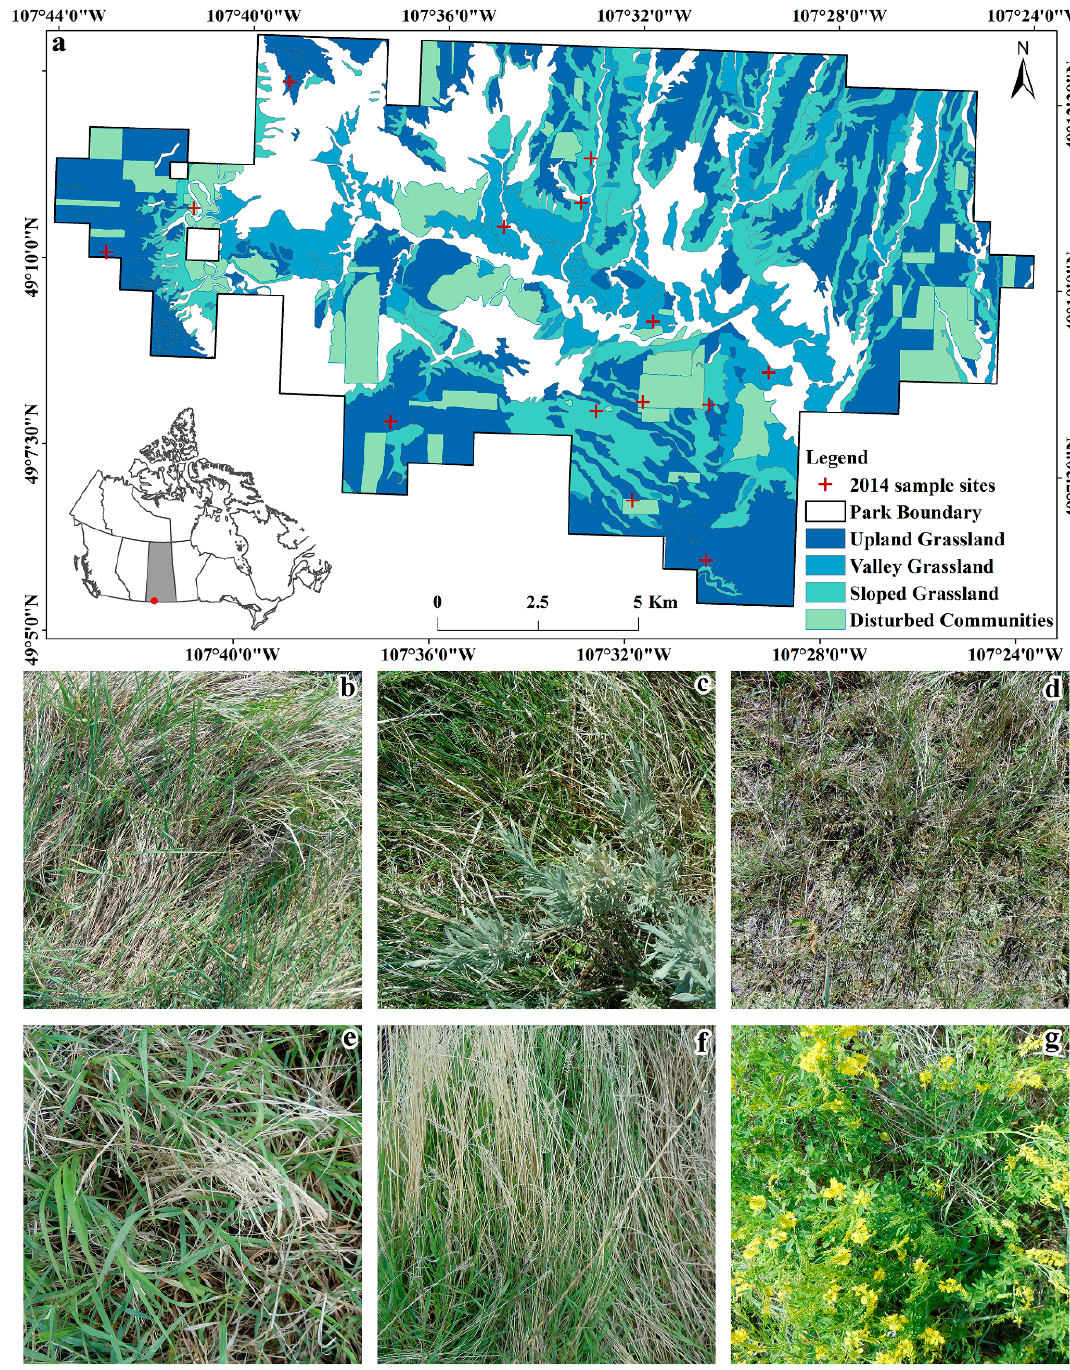
Figure 1. Vegetation communities in Grassland National Park (GNP). ( a ) Vegetation communities in GNP first surveyed in 1983 and disturbed community data updated in 1995. ( b ) Upland grassland. ( c ) Valley grassland. ( d ) Sloped grassland. ( e ) Disturbed community with Smooth Brome ( Bromus inermis Layss. ). ( f ) Disturbed community with Crested Wheatgrass ( Agropyron cristatum ). ( g ) Disturbed community with Sweet Clover ( Melilotus officinalis ).